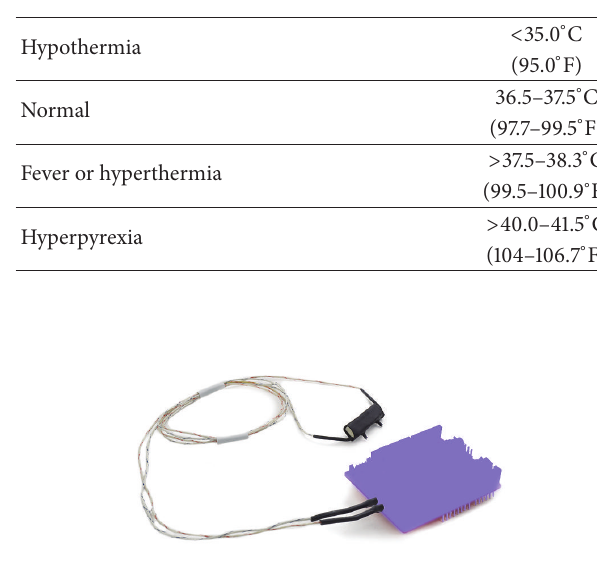
Table 1: Body temperature under certain illness [12].